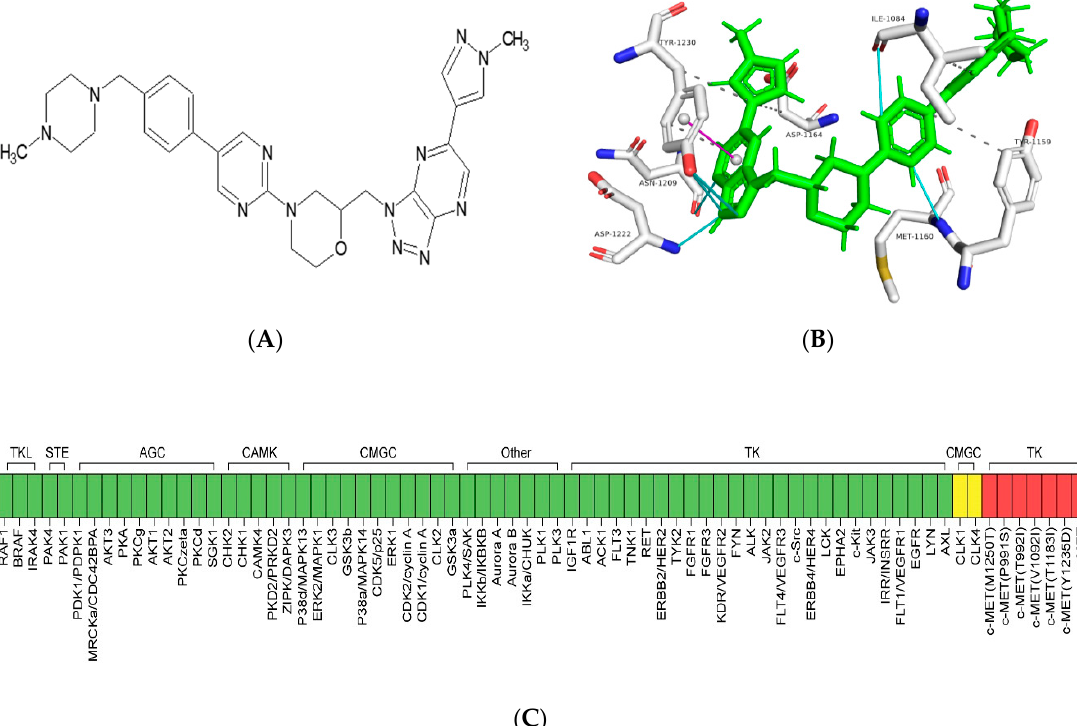
Figure 1. Characteristics of ABN401 as a highly potent and selective c-MET inhibitor. ( A ) Chemical structure of ABN401. ( B ) The binding modes of ABN401 determined using molecular docking simulation. ABN401 in the binding site of the c-MET kinase domain (white colored) is indicated with a line-stick model. The heavy atoms of nitrogen, oxygen, and sulfur are colored in blue, red, and yellow, respectively. The interactions between protein and inhibitors are shown, including hydrophobic interactions (gray colored), hydrogen bonds (cyan colored), and pi-stacking (magenta colored). ( C ) Kinase selectivity profiling of ABN401 in a panel of 571 kinases. TKL: Tyrosine kinase-like, STE: Homologs of yeast Sterile 7, 11, 20 kinases, AGC: Containing PKA, PKG, PKC families, CAMK: Calcium / calmodulin-dependent protein kinase, CMGC: Containing CDK, MAPK, GSK3, CLK families, TK: Tyrosine